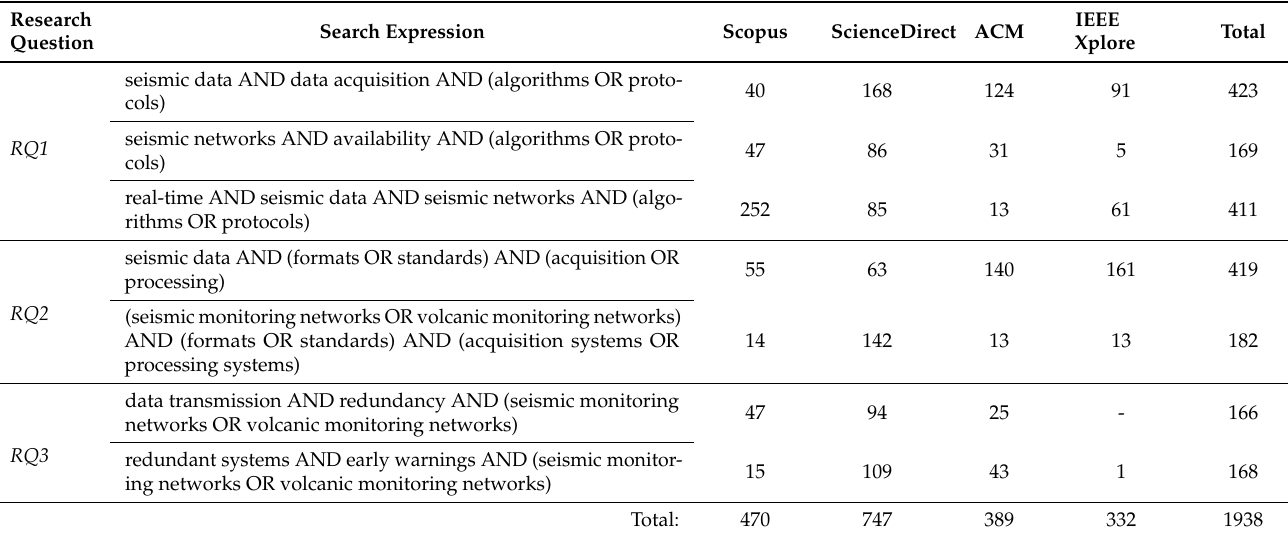
Table 2. Summary of search